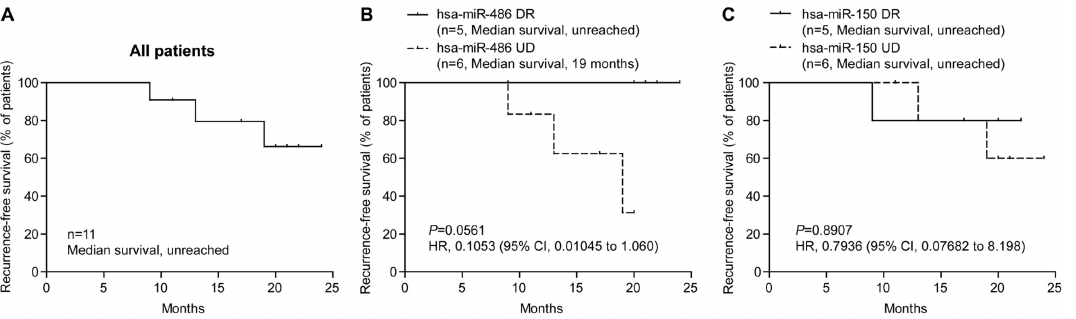
Fig 4. Associations of changes of plasma levels for miR-486 and miR-150 before and after surgery and recurrence-free survival of patients. Association of RFS and plasma miRNA level changes before and after surgery was plotted with Log-rank (Mantel-Cox) Test. (A) Overall RFS of all NSCLC patients. (B) Association of RFS and change of plasma miR-486 level before and after surgery. (C) Association of RFS and change of plasma miR-150 level before and after surgery. DR, down-regulated; UD, un-down-regulated; HR, hazard ratio; CI, confidence interval.